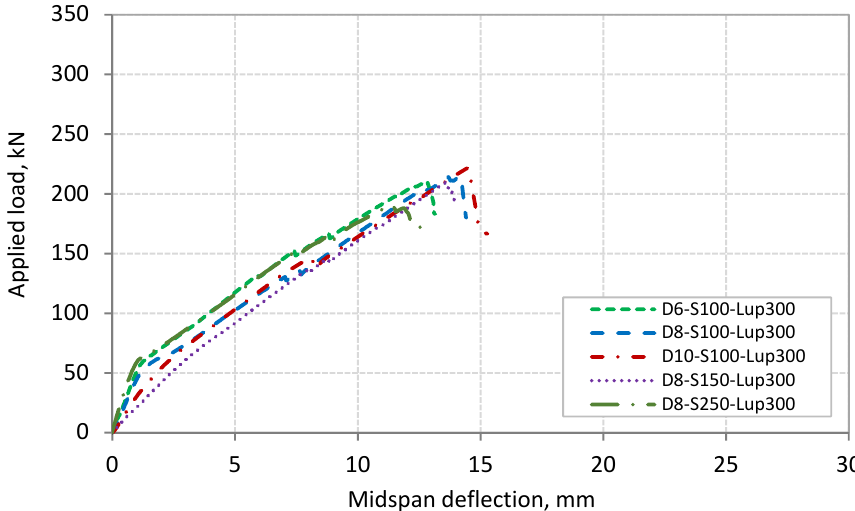
Figure 10. Applied load–deflection relationship for beams of Series 2.